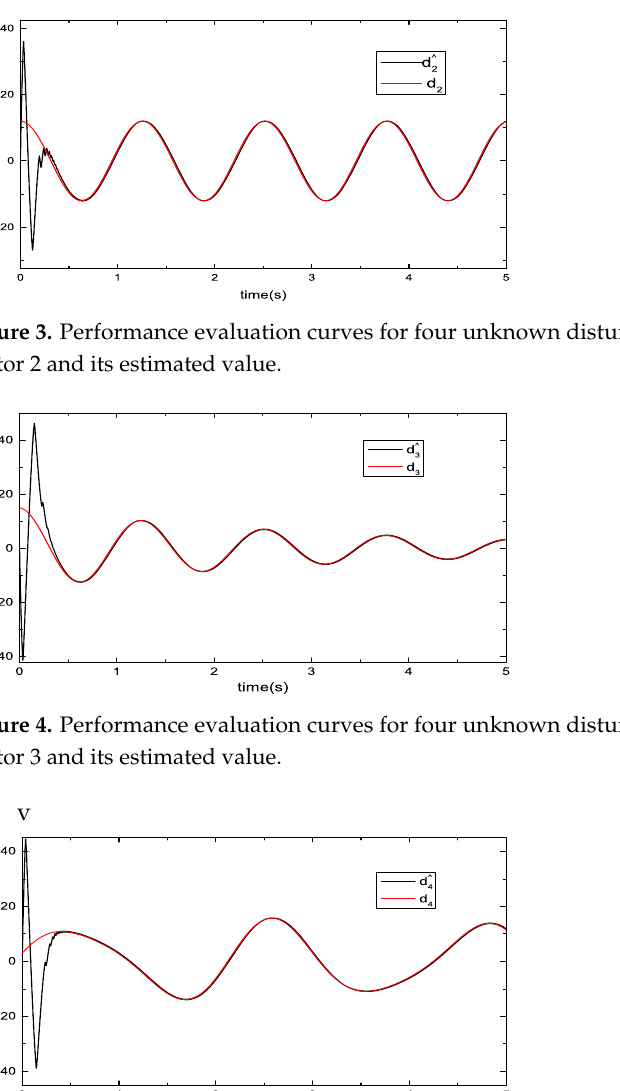
Figure 2. Performance evaluation curves for four unknown disturbance observers: disturbance of motor 1 and its estimated value.